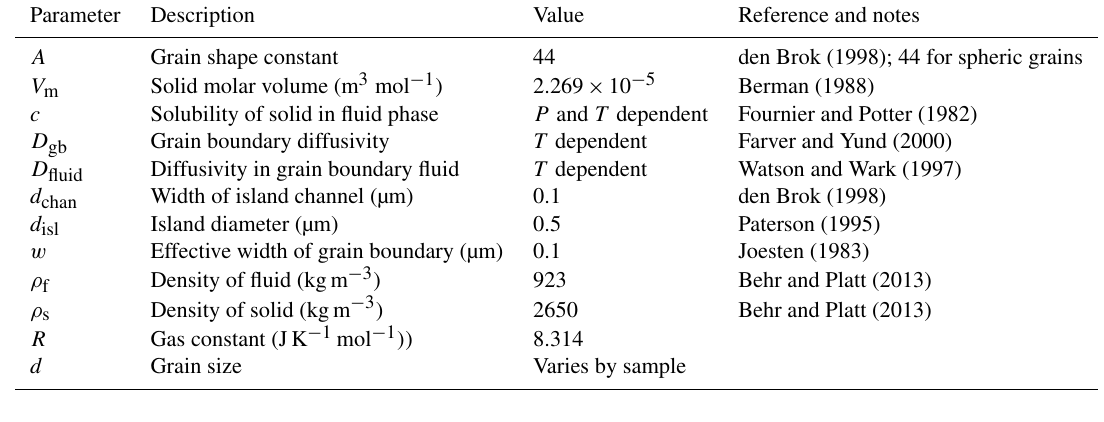
Table E1. Parameters used for pressure-solution